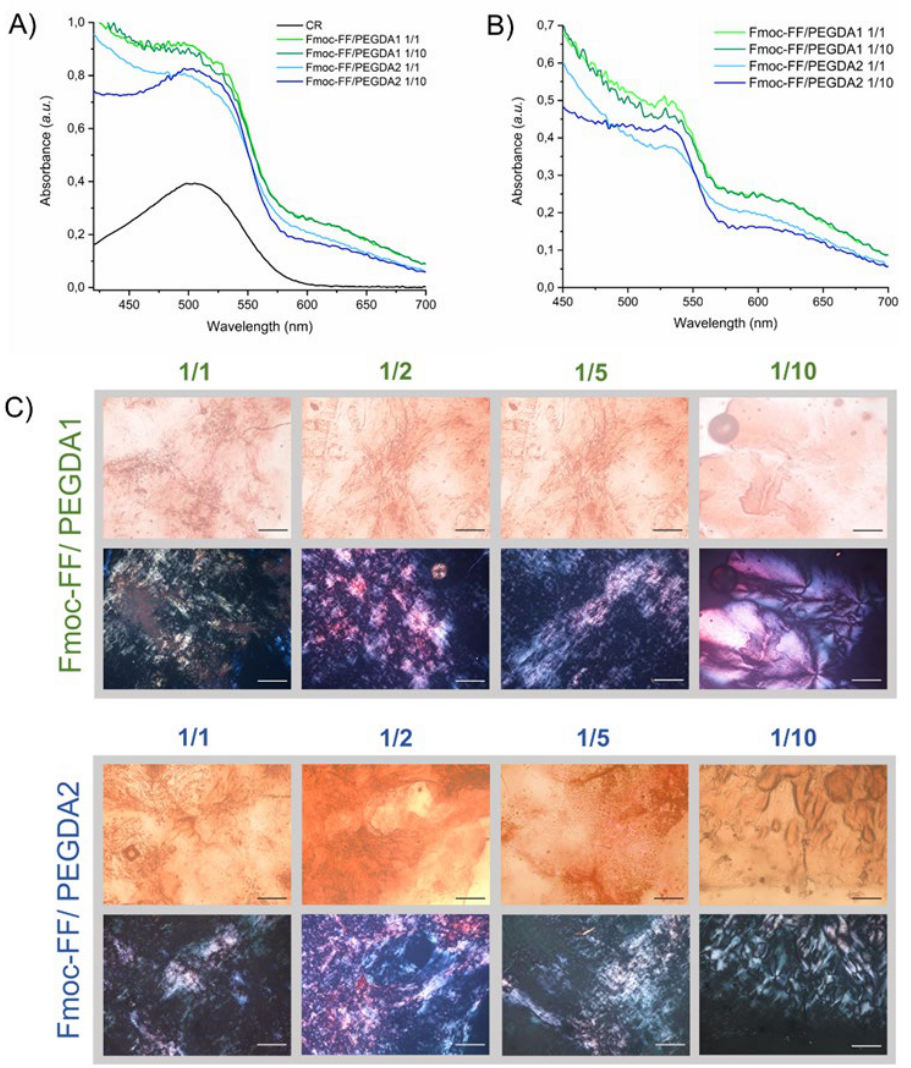
Figure 5. CR assay in solution and in the solid state. UV-Vis spectra of CR alone and co-incubated with Fmoc-FF/PEGDA1 ( A ) or with Fmoc-FF/PEGDA2 ( B ) at the different molar ratios. ( C ) Staining of Congo Red xerogels in both bright field (first row) and under cross-polarized light (second row). Scale bar =100 µm.